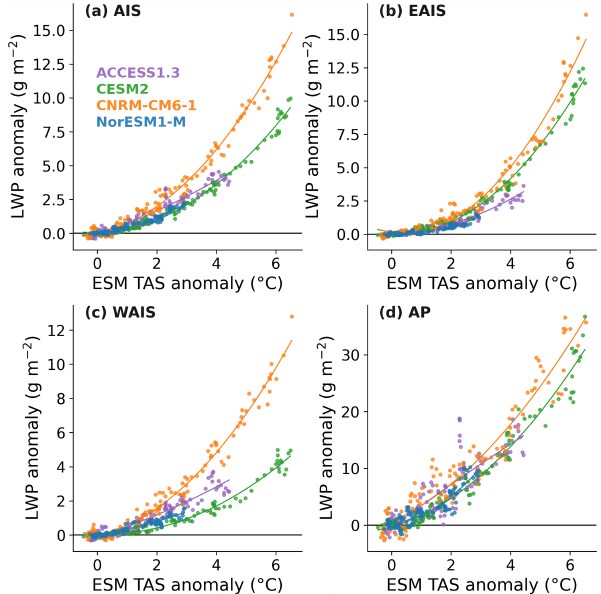
Figure 6. Changes in mean summer IWP (gm − 2 ) as projected by MAR forced by ACCESS1.3 (purple), CESM2 (green), CNRM- CM6-1 (orange), and NorESM1-M (blue) for all the Antarctic ice shelves (a) and the ice shelves of the East Antarctic sector (b) , the West Antarctic sector (c) , and the Antarctic Peninsula (d) compared to mean summer ESM near-surface temperature ( ◦ C) over the re- gion 90–60 ◦ S.